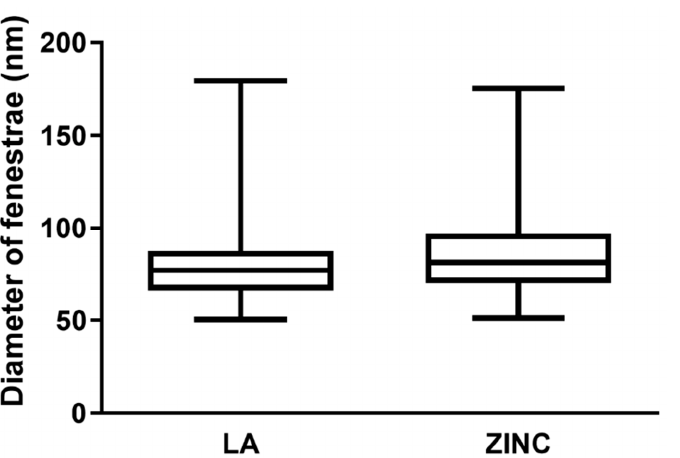
Figure 5. Size distribution of fenestrae diameter induced by zinc or LA. The distribution of fenestrae diameters was similar in LA and ZnSO 4 treated cells. A total of 775 fenestrae from LA-treated cells and 393 fenestrae from ZnSO 4 -treated cells were assessed from 3 independent experiments.